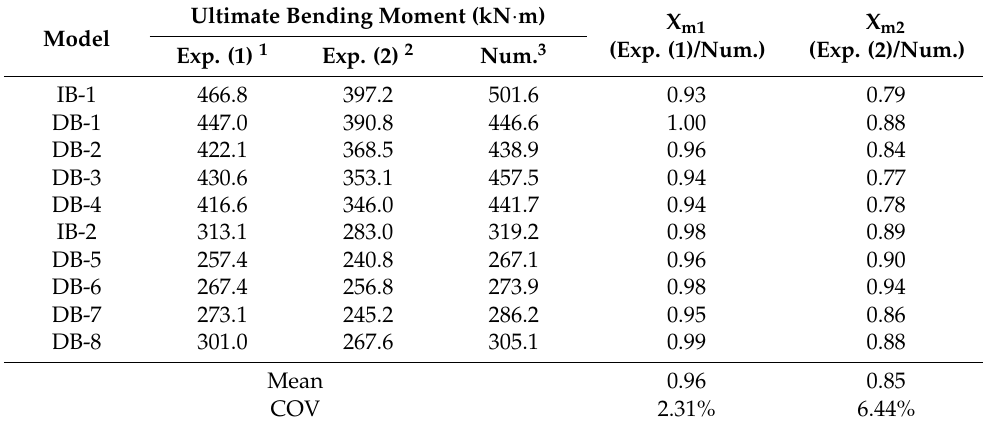
Table 10. The comparison of the numerical predictions with the test results: bending simulation. Model